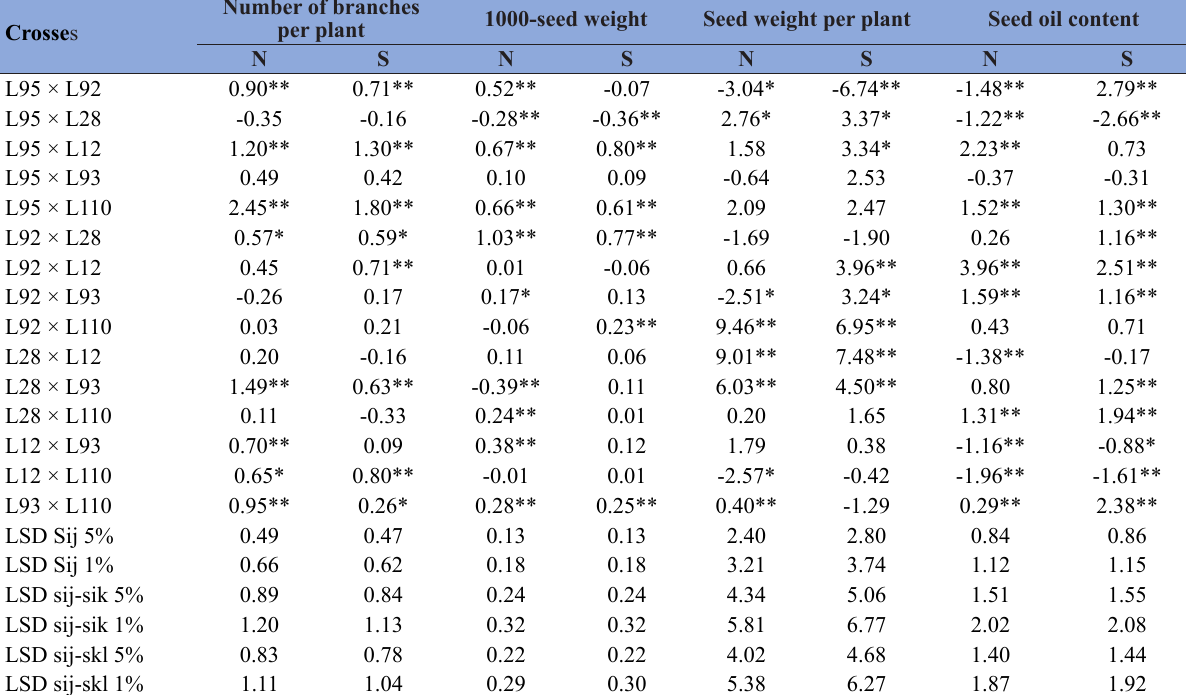
cross combinations for number of branches per plant, 1000-seed weight, seed 1